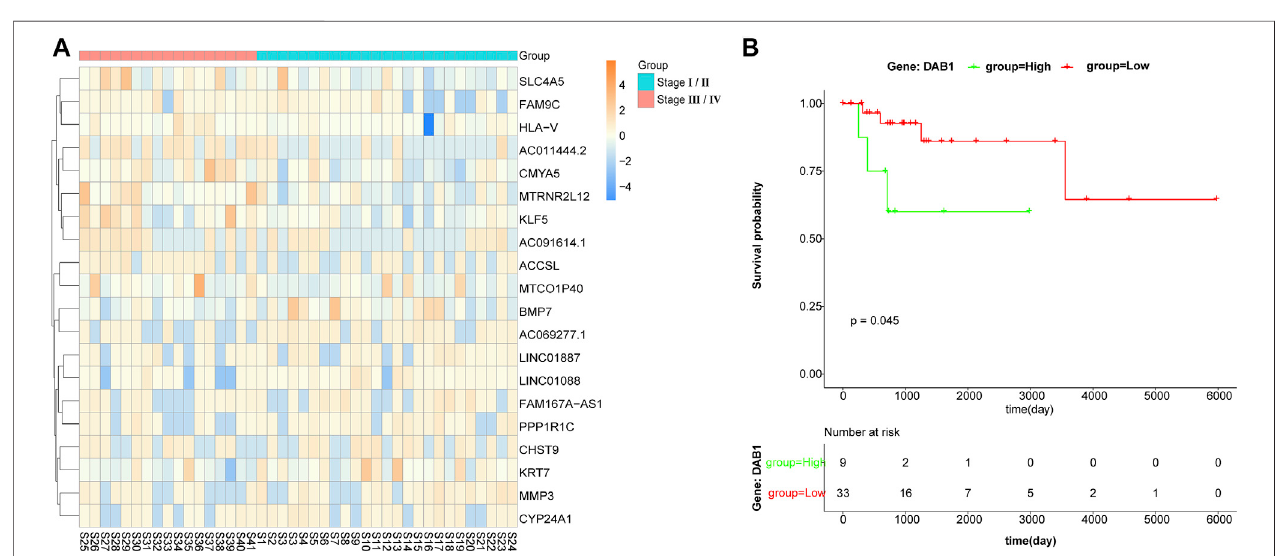
FIGURE 2 | Analysis of differentially expressed genes. (A) Heat map of the top 10 differentially expressed genes. The x -axis represents different samples from TCGA,blueindicatessamplesatlimitedstage (stageI/II) andredindicates samplesatadvanced stage(stageIII/IV). The y -axisrepresentsdifferentially expressedgenes. (B) Survival curve of the association between the expression levels of DAB1 and survival time after diagnosis with